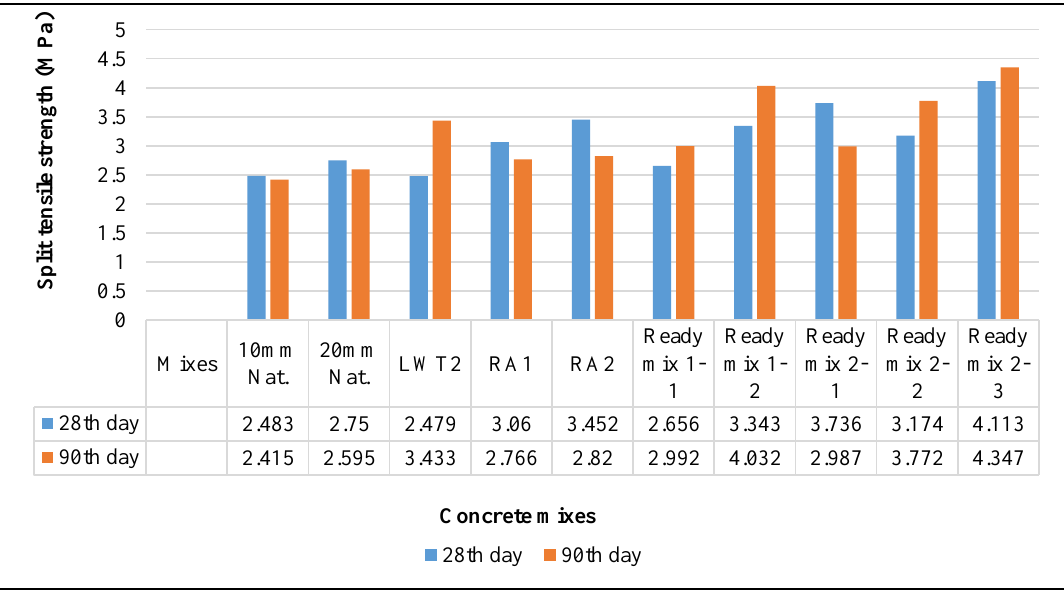
Figure 7. Split strength for different concrete mixes at 28- and 90-day.